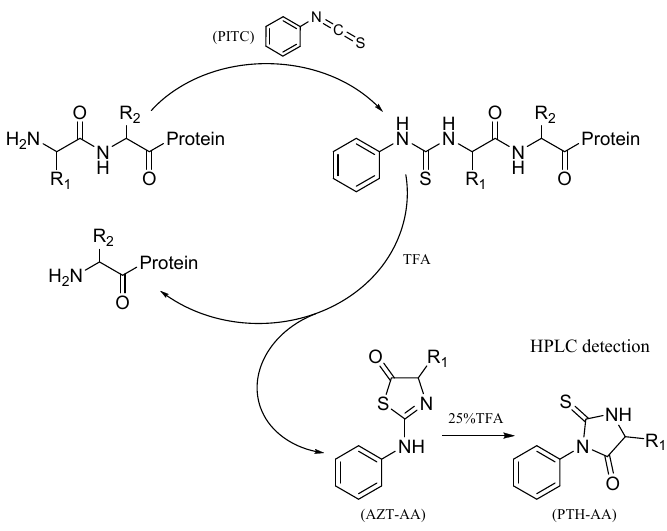
Figure 15. N-terminal sequencing cycle in the Edman degradation assay.